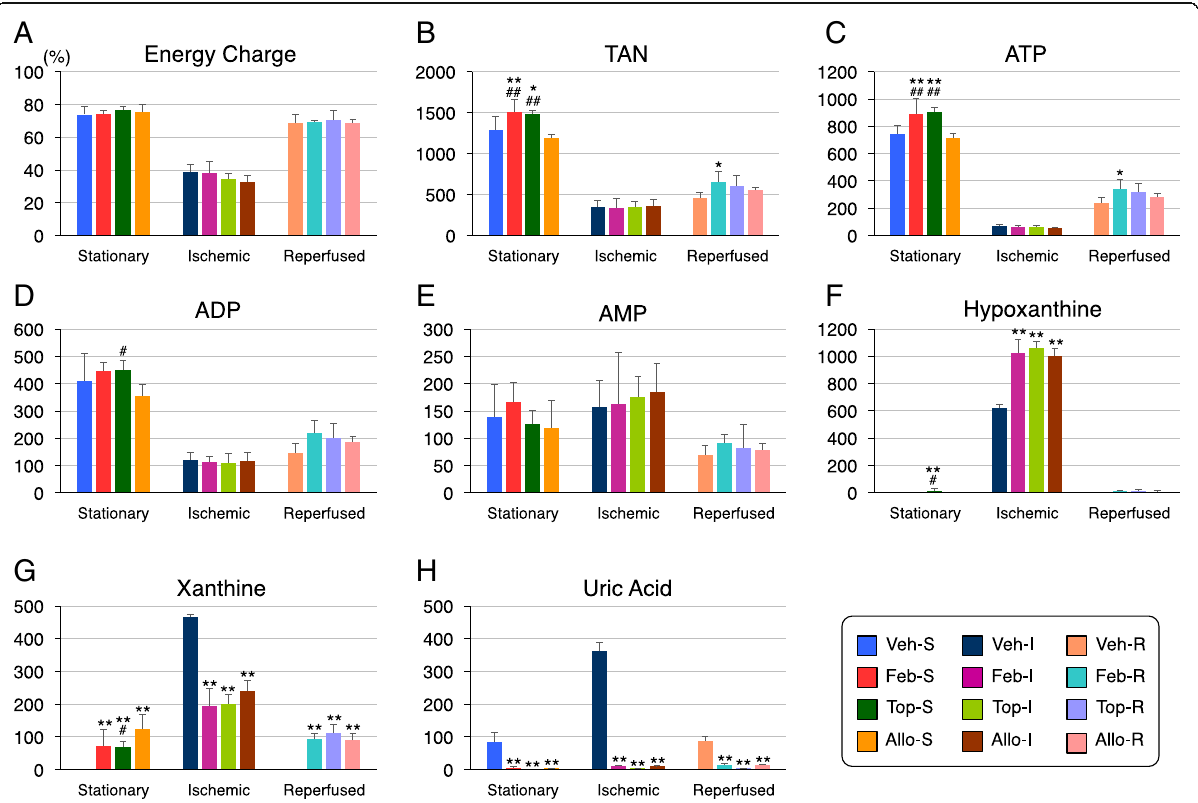
Fig. 2 Purine nucleotide concentrations measured by HPLC. Concentrations of ATP, ADP, AMP, hypoxanthine, xanthine, and uric acid were measured by HPLC. In the stationary state, ATP and TAN levels were significantly higher in the Feb-S and Top-S groups than in the Veh-S and Allo-S groups ( b , c ), whereas xanthine was not detected (ND) in the Veh-S group, and uric acid levels decreased in the inhibitor-treated groups ( g , h ). ADP levels increased in the Feb-S and Top-S group compared with that in the Veh-S group ( d ). In the ischemic state, energy charge and concentrations of purine nucleotide decreased considerably from the stationary condition ( a , b , c , d ); hypoxanthine levels were higher, and xanthine and uric acid levels were lower in the inhibitor-treated groups ( f , g , h ). In the reperfused state, TAN and ATP levels were higher in the Feb-R group than in the Veh-R group (B, C); hypoxanthine and xanthine remained positive only in inhibitor-treated groups ( f , g ), and uric acid in Veh-R rats returned to the stationary level ( h ). Energy charge and TAN were calculated as follows: energy charge= ATP + 0.5*ADP/ATP + ADP + AMP, TAN = ATP + ADP + AMP. Concentrations are expressed as nmol/g wet weight; the data are presented as the mean ± SEM ( n = 5~6). * P < 0.05 and ** P < 0.01 versus Veh; #P < 0.05 and ##P < 0.01 versus Allo; one-way ANOVA followed by Games – Howell ’ s